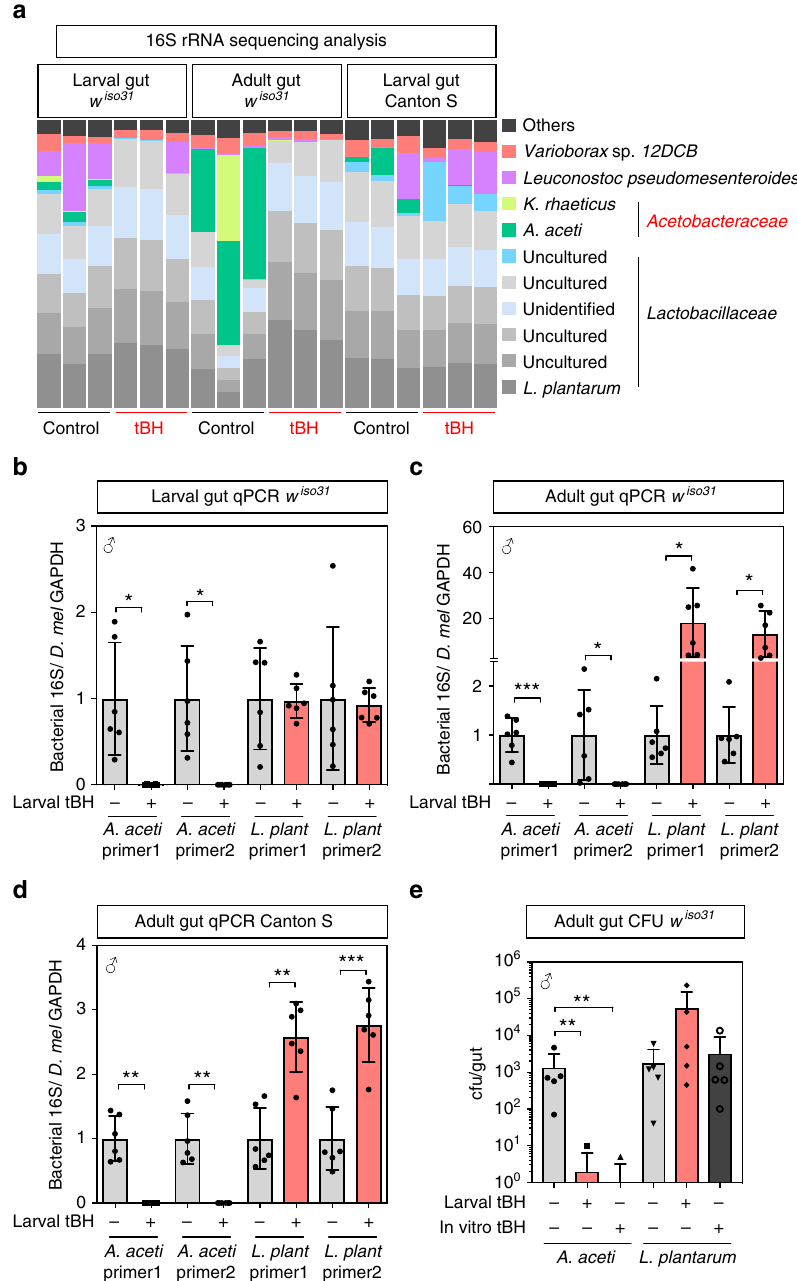
Fig. 3 tBH selectively depletes Acetobacteraceae from the microbiome. a 16S metagenomic analysis from conventional control (black) or tBH-treated (red) larval gut (left) or adult gut (middle) from w iso31 fl ies or larval gut from Canton S fl ies (right). Each column represents a biological replicate and colours indicate operational taxonomic units (OTUs). b – d Quantitative PCR with species-speci fi c primers for bacteria in larval ( b ) or adult ( c ) guts of w iso31 and Canton S ( d ) male fl ies. Mean ± SEM ( n = 6). e Quanti fi cation of colony-forming units (cfu) in the gut from control (grey) or tBH-experienced (red) w iso31 male fl ies. Control gut samples were also plated on 5 mM tBH-containing agar (in vitro tBH+). Mean ± SEM ( n = 5). * p < 0.05, ** p < 0.01, *** p <